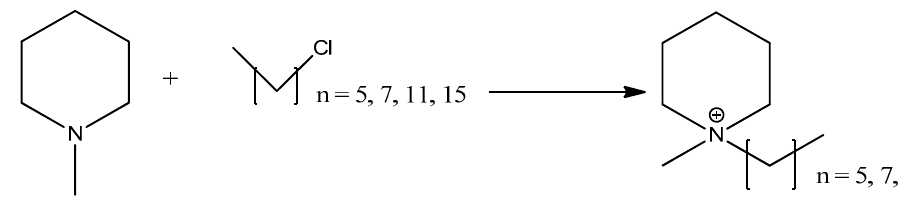
Figure 16. Quaternization of n -methyl-piperidine.